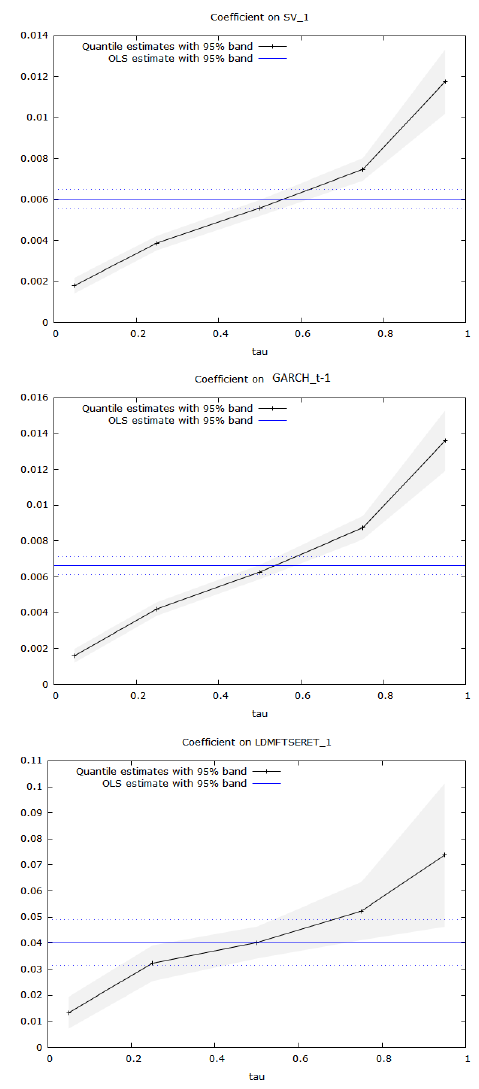
Figure 9. Tau plots of quantile-regression